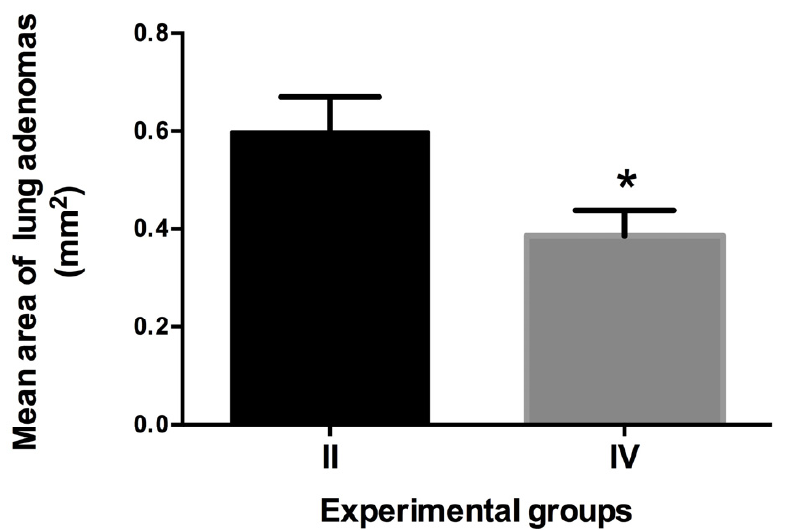
Figure 5. Area (mm 2 ) occupied by lung adenomas. In group II (urethane) the adenomas were larger compared with those observed in group IV (urethane-V). N = 10, values expressed as the mean area ± SEM (two-tailed Student’s t -test with Welch’s correction, p ≤ 0.05). * Statistically significant differences between group II versus group IV.